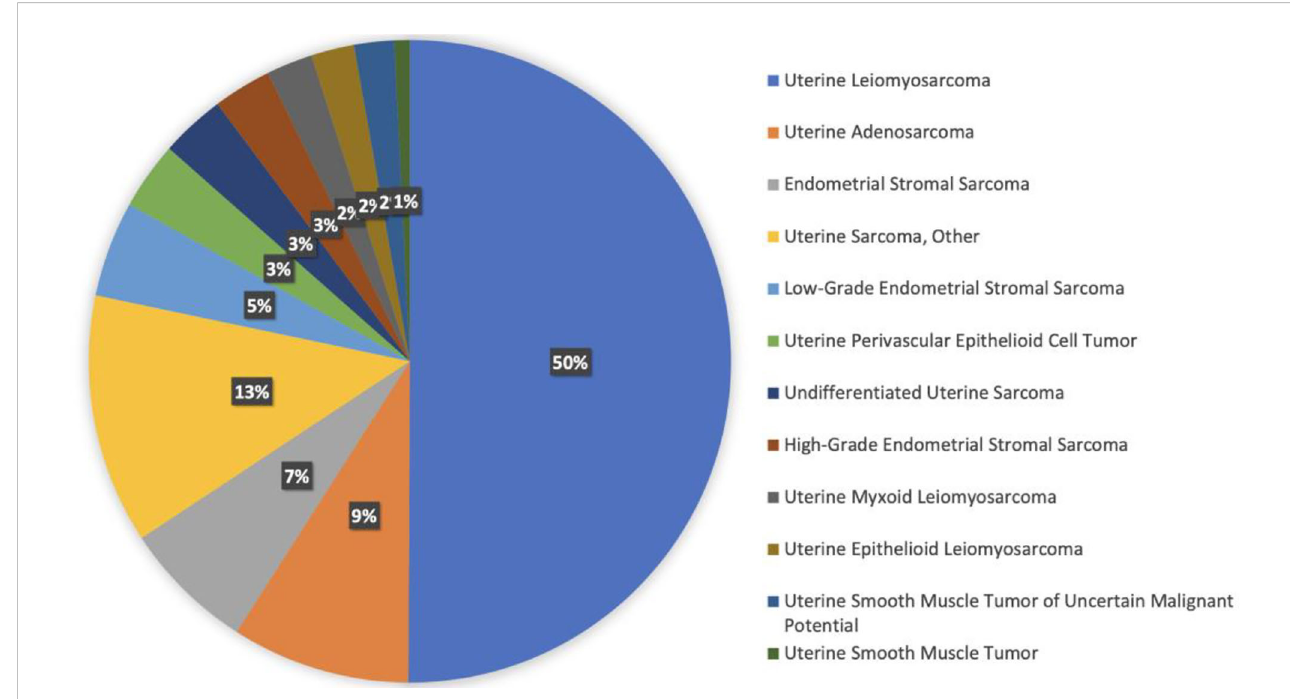
FIGURE 3 Histology distribution within the uterine sarcoma